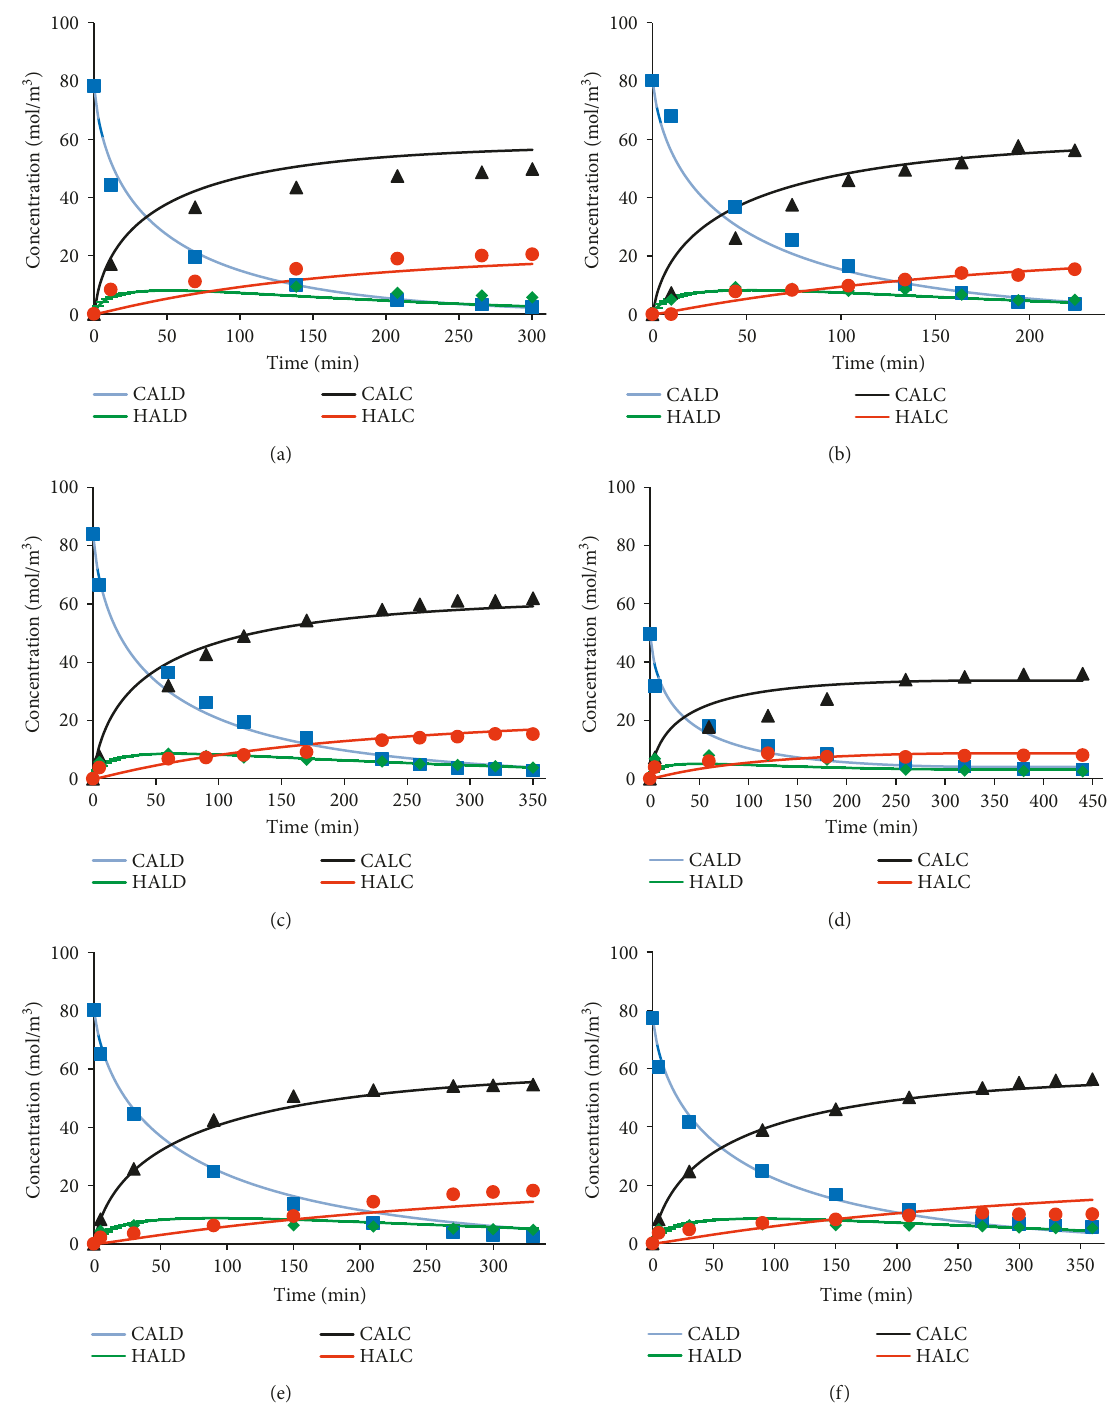
Figure 4: Comparison between the experimental and bulk model results. Experimental conditions are (a) ( T � 110 ° C, P � 30 bar, initial CALD concentration � 78.25mol/m 3 ), (b) ( T � 110 ° C, P � 30 bar, initial CALD concentration � 80.19mol/m 3 ), (c) ( T � 110 ° C, P � 20 bar, initial CALD concentration � 83.88mol/m 3 ), (d) ( T � 110 ° C, P � 30 bar, initial CALD concentration � 49.57mol/m 3 ), (e) ( T � 90 ° C, P � 30 bar, initial CALD concentration � 80.15mol/m 3 ), and (f) ( T � 90 ° C, P � 30 bar, initial CALD concentration � 77.23mol/m 3